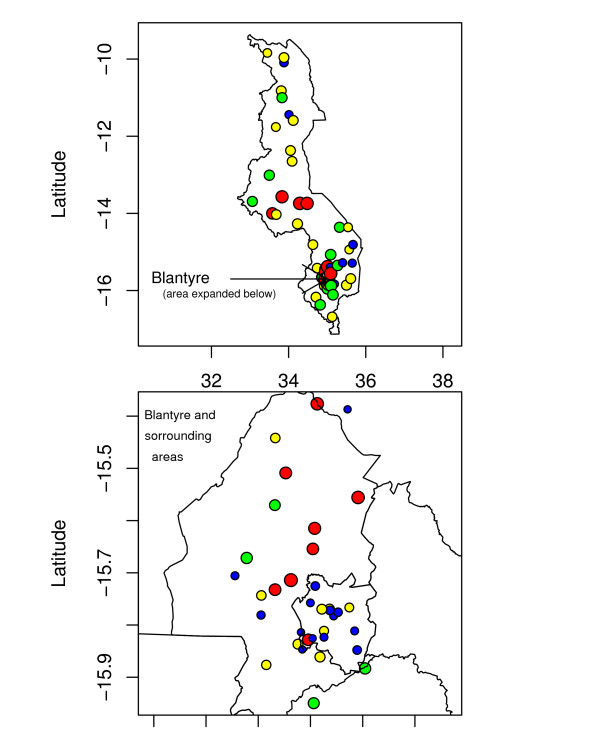
Point map showing malaria prevalence of children aged 1–10 years, at 73 locations in Malawi from 1977 to 2002. Data divided into quartile: Blue: 0–25%, Green: 26–50%, Yellow: 51–75%, Red: 76–100%.